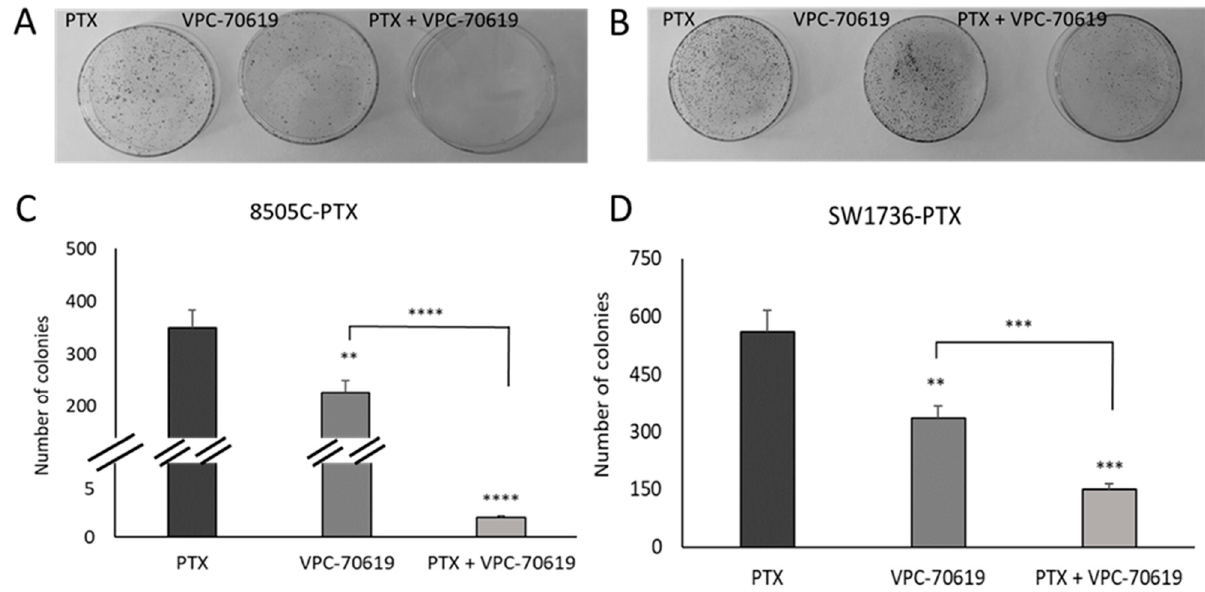
Figure 9. Effects of VPC-70619 treatment on colony-forming ability in resistant ATC cell lines. The ability to form colonies in an anchorage-dependent way was studied by colony formation assay in both cell lines following single treatment with paclitaxel (PTX), VPC-70619 and in combination with paclitaxel (PTX+VPC-70619). Panels ( A , C ) represent 8505C-PTX cells, while panels ( B , D ) represent SW1736-PTX cells. In panel C and panel D, histograms represent the number of colonies per cell line. n = 3. ** p < 0.01, *** p < 0.001, **** p < 0.0001.